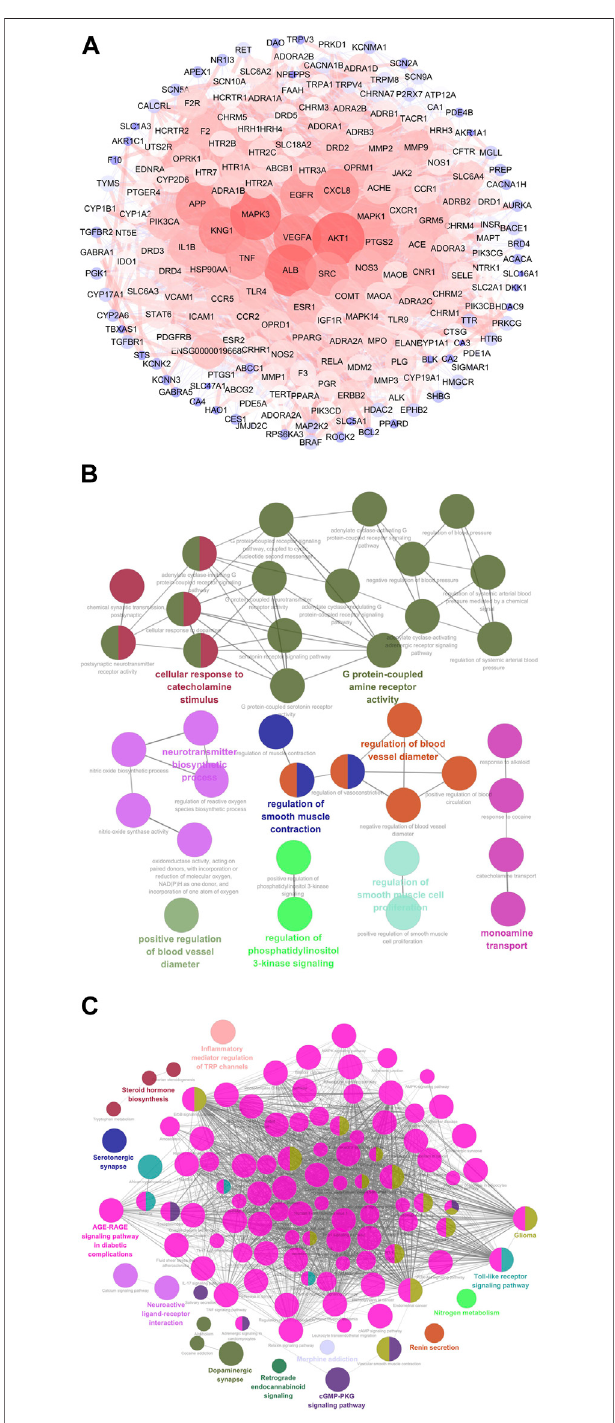
FIGURE 6 | Network pharmacology analysis of CRCR in migraine treatment. (A) Theprotein – protein interaction networkof201potential targets responsible for CRCR against migraine. The nodes represent targets, while the edges represent the association between nodes and nodes, and the node size represents degree value. (B) The Gene Ontology (GO) biological process analysis of potential targets by ClueGo. (C) The Kyoto Encyclopedia of Genes and Genomes (KEGG) enrichment analysis of potential targets by